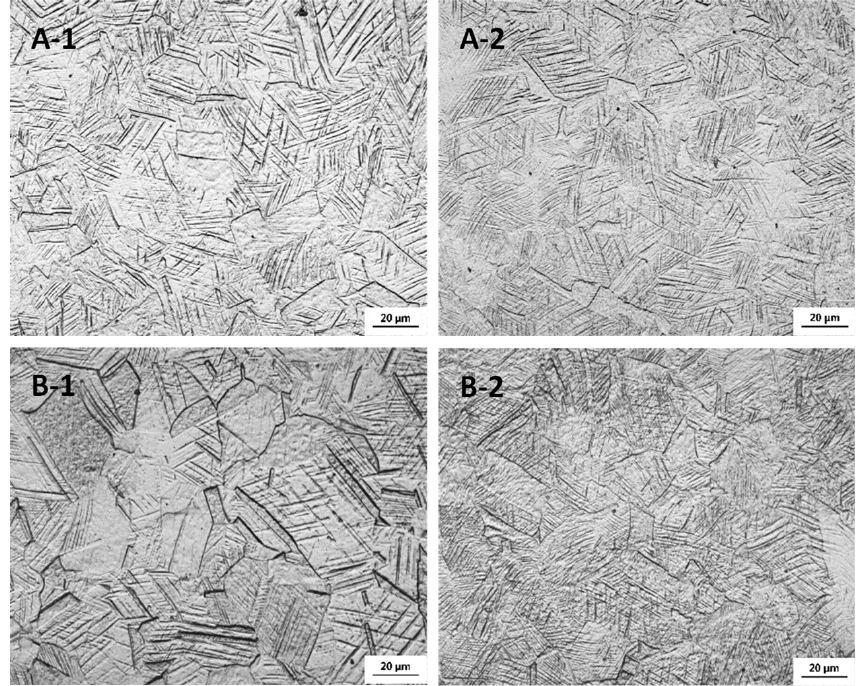
Figure 2. Cross section OM micrographs of drawn wires, 1st drawn wire of process A ( A ‐ 1 ), 2nd drawn wire of process A ( A ‐ 2 ), 1st drawn wire of process B ( B ‐ 1 ), 2nd drawn wire of process B ( B ‐ 2 ).